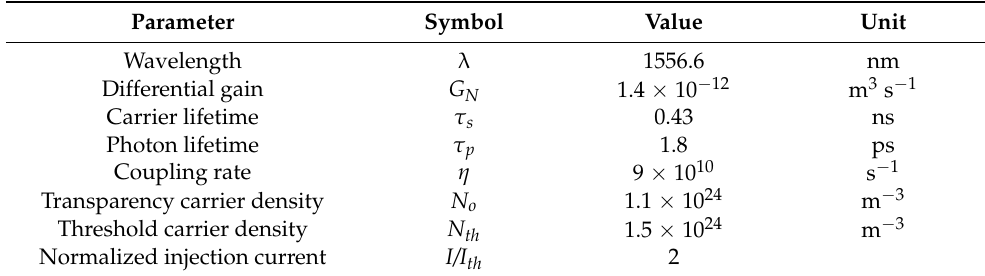
Table 1. Parameters used in this study’s